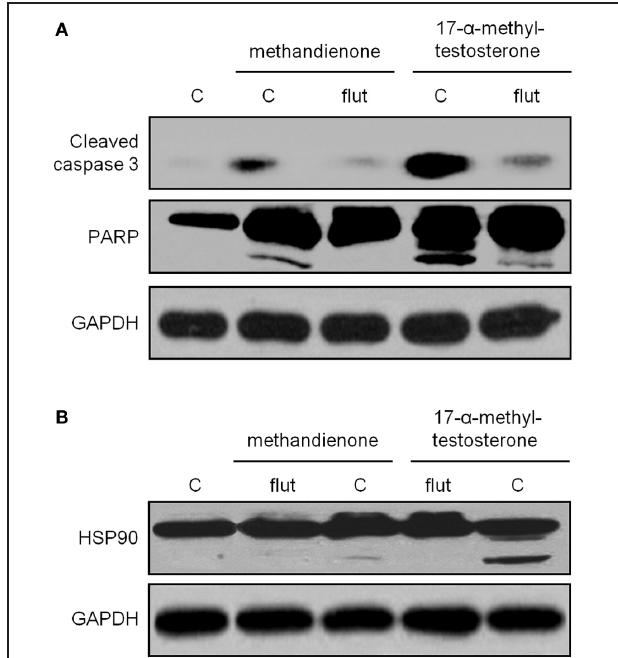
FIGURE 5 | Immunoblots for caspase 3 ( top panel ), PARP ( second panel ) (A) and Hsp90 (B) in PC12, control treated or treated for 48h with 75 μ M methandienone and 17- α -methyltestosterone alone or with 10 μ M hydroxyflutamide. Indicators of apoptosis are decreased in the presence of hydroxyflutamide. GAPDH was used as the loading control for all blots ( bottom panels ).